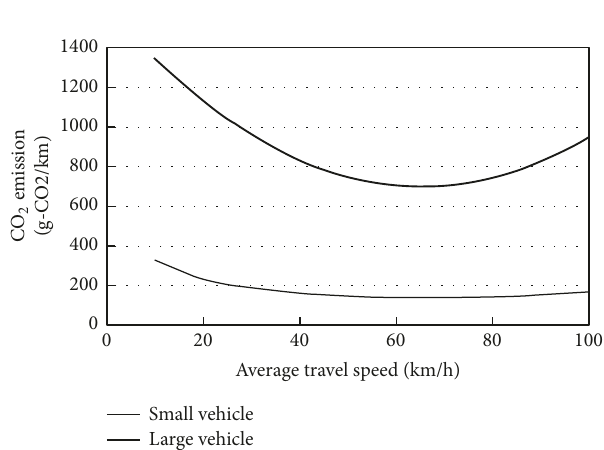
Figure 5: Relationship between average speed and CO 2 emissions according to